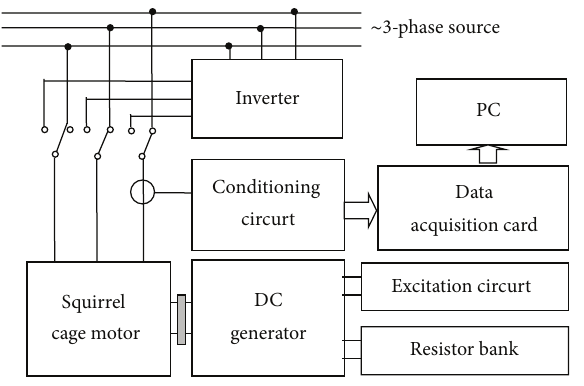
Figure 4: Schematic diagram of the experiment.